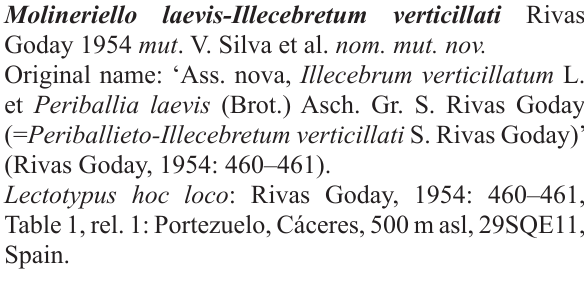
Table 1, rel. 1: Portezuelo, Cáceres, 500 m asl, 29SQE11,